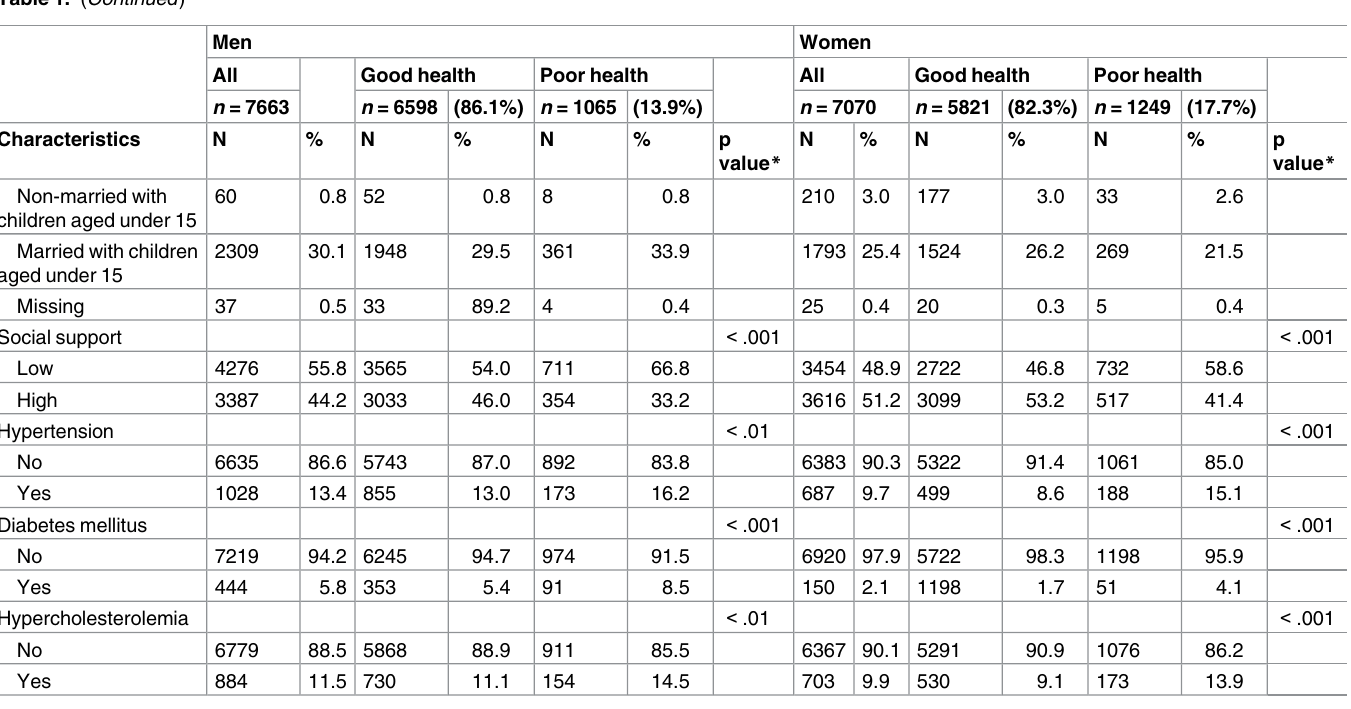
roles. Both men and women who reported having lower social support and medical histories of hypertension, diabetes mellitus, and hypercholesterolemia were more likely to report poor self-rated health. Table 2 shows gender-specific adjusted odds ratios (ORs) for poor self-rated health asso- ciated with work–family conflict. We identified statistically significant associations between work–family conflict and poor self-rated health among both men and women. High WF conflict, as well as high FW conflict, was associated with poor self-rated health among both men and women. The adjusted ORs (95% confidence interval [CI]) for poor self-rated health in the high WF conflict and high FW conflict group were 2.46 (95% CI, 2.04–2.97) for men and 3.54 (95% CI 2.92–4.30) for women, with reference to the low WF conflict and low FW conflict group. The association between work–family conflict and poor self- rated health among women was relatively stronger than that among men (interaction for p = 0.02). The subgroup analysis by household income showed that the association between work– family conflict and self-rated health was modified by household equivalent income only among women in Table 3 (interaction for p = 0.01). The adjusted ORs (95% CI) for poor self- rated health of the women who reported high WF conflict and high FW conflict with reference to those reporting low WF conflict and low FW conflict, were 4.63 (95% CI, 3.42–6.27) in the lowest household income group, 3.49 (95% CI, (2.45–4.99) in the intermediate household income group, and 2.45 (95% CI, 1.72–3.50) in the highest household income group. For men, no modification by household income was